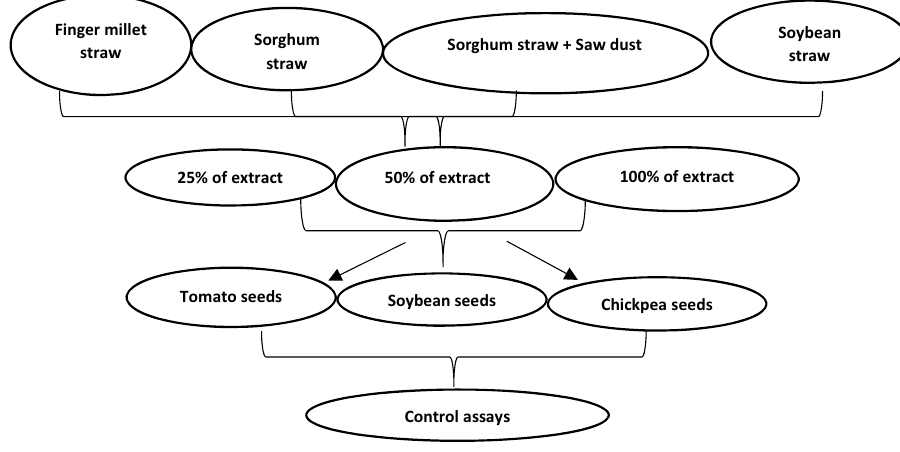
Fig. 1 Experimental design